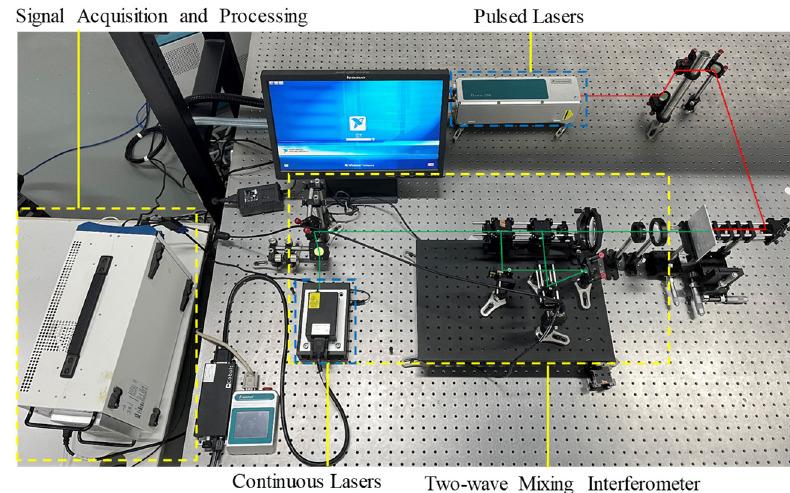
Figure 3. A laser ultrasonic system pulsed laser and an interferometer are used to generate and detect ultrasonic waves. Table 2. Laser parameters.